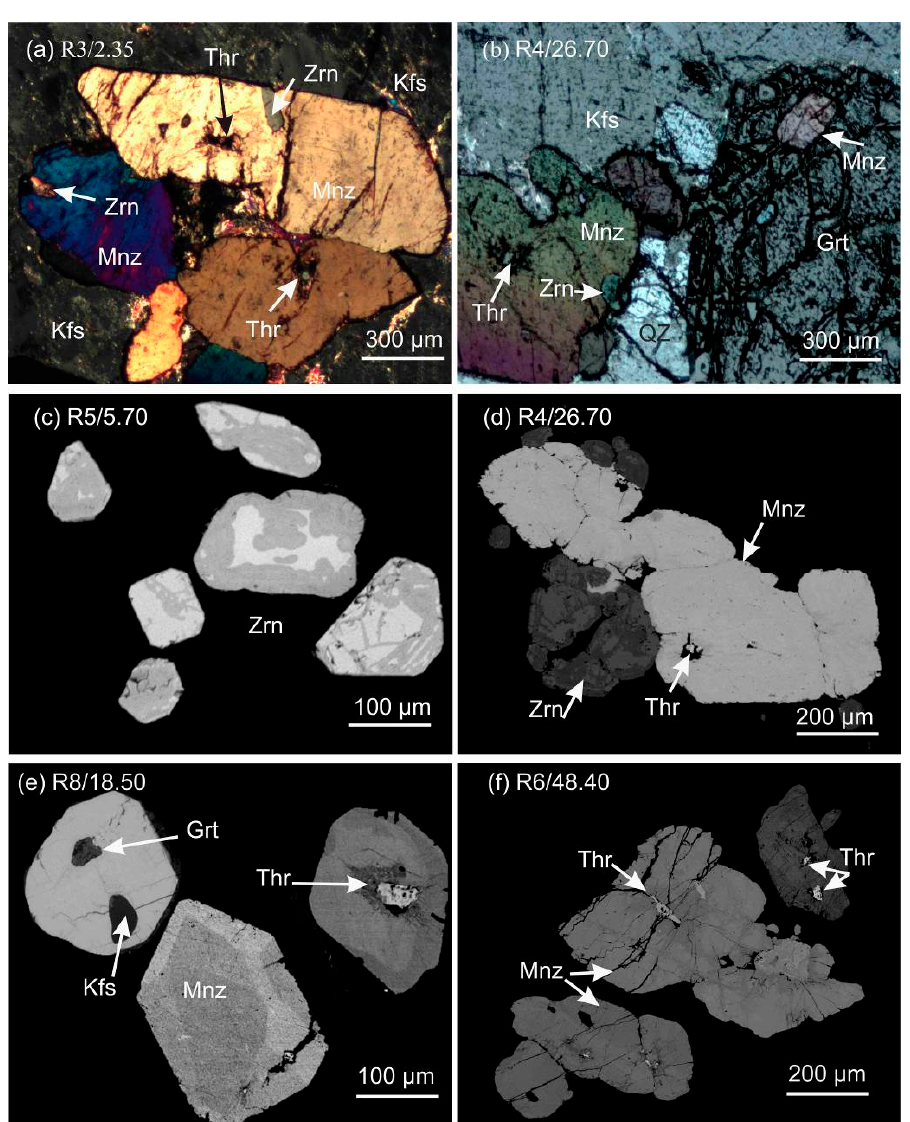
Figure 17. Polarizing microscope and back-scattered electron images of REE-bearing minerals in the monazite bearing granite at Kovela; ( a , b ) Coarse hexagonal and elongated monazite (Mnz) overgrowth with other monazite in contact with feldspar (kfs), quartz (Qz) and Garnet (Grt); ( c ) Euhedral to subhedral zircon (Zrn), shows typical oscillatory zoning and/or sector zoning; ( d ) Monazite (Mnz) intergrown with zircon (Zrn); ( e ) Monazite crystals illustrating zoning types and different inclusions; ( f ) Thorium-silicate materials occurring as inclusions or as disseminated crystals within monazite grains.